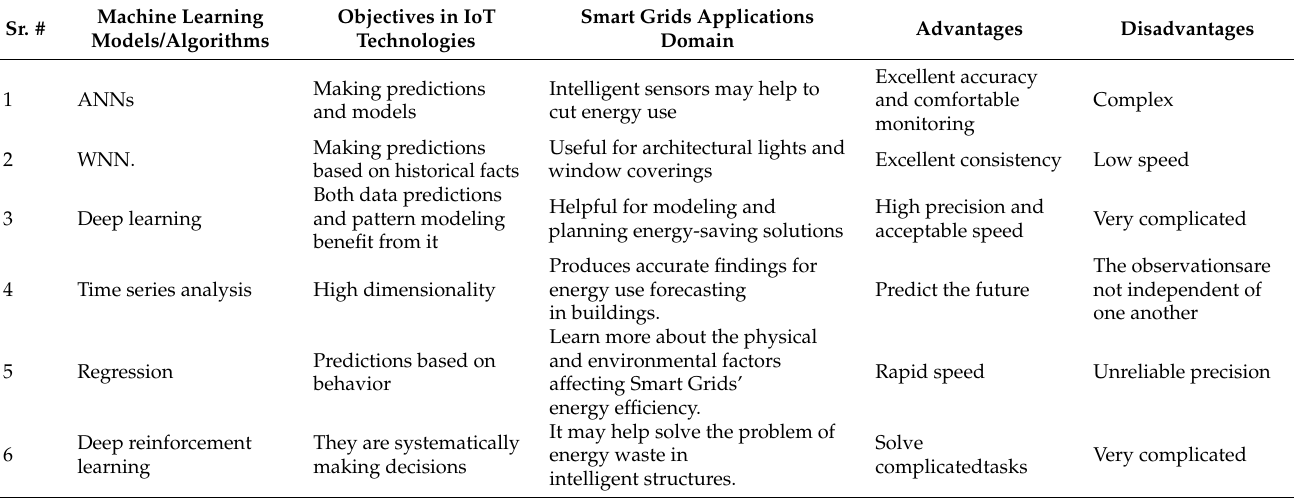
Figure 10. Application of genetic algorithms in machine learning [99]. Table 4. The objectives of IoT technologies, the domain of machine learning algorithms, and the context of smart grid